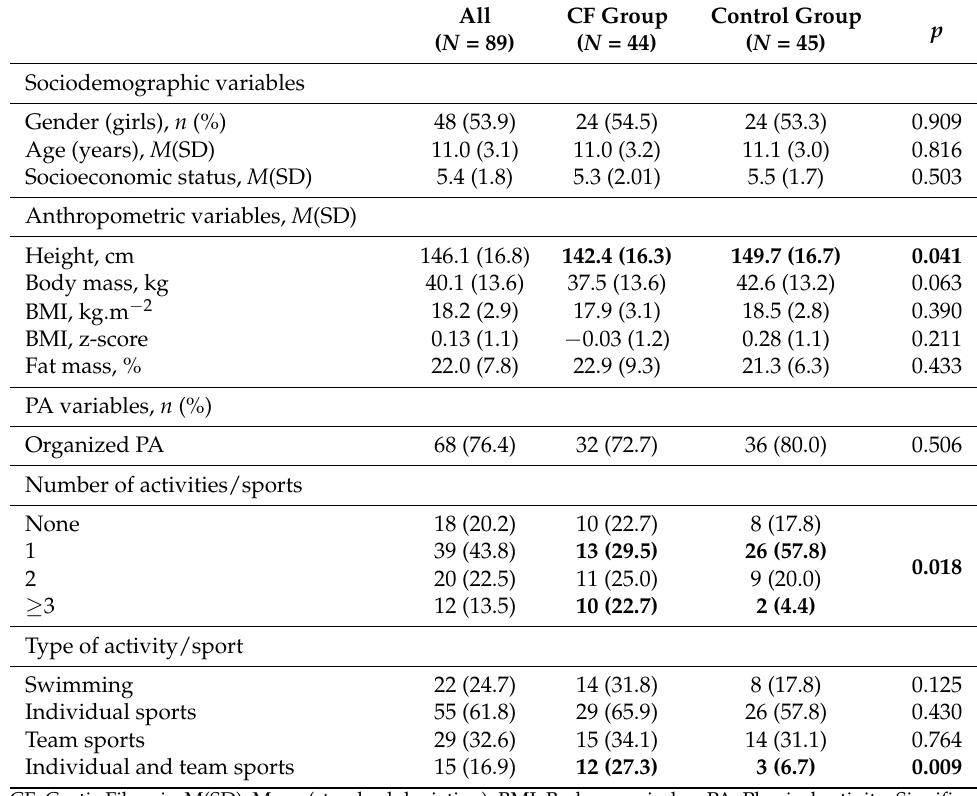
Table 1. Characteristics of the